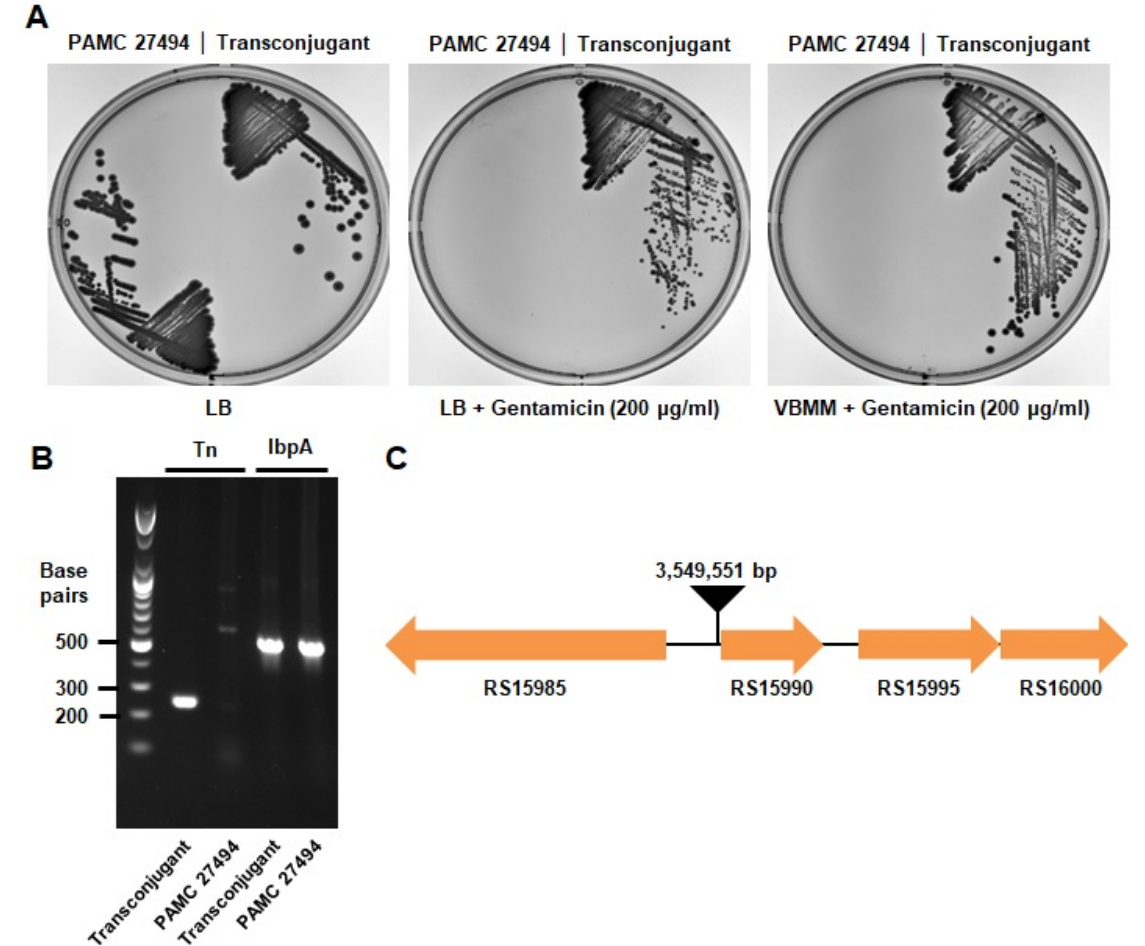
Figure 2. Confirmation of transposon insertion in the P. antarctica PAMC 27494 strain. ( A ) The P. antarctica PAMC 27494 strain and its transconjugant were streaked on LB, LB–gentamicin (200 µ g/mL), and VBMM–gentamicin (200 µ g/mL) and incubated at 20 ◦ C for four days. ( B ) To verify the insertion of the transposon, PCR was performed by using two primer sets for targeting transposon-specific sequences and the ibpA gene as a PCR control. ( C ) By performing inverse PCR and subsequent sequencing, the insertion site of the transposon was determined, which is at 3,549,551 bp, the intergenic region between RS15985 and RS15990 genes in P. antarctica .